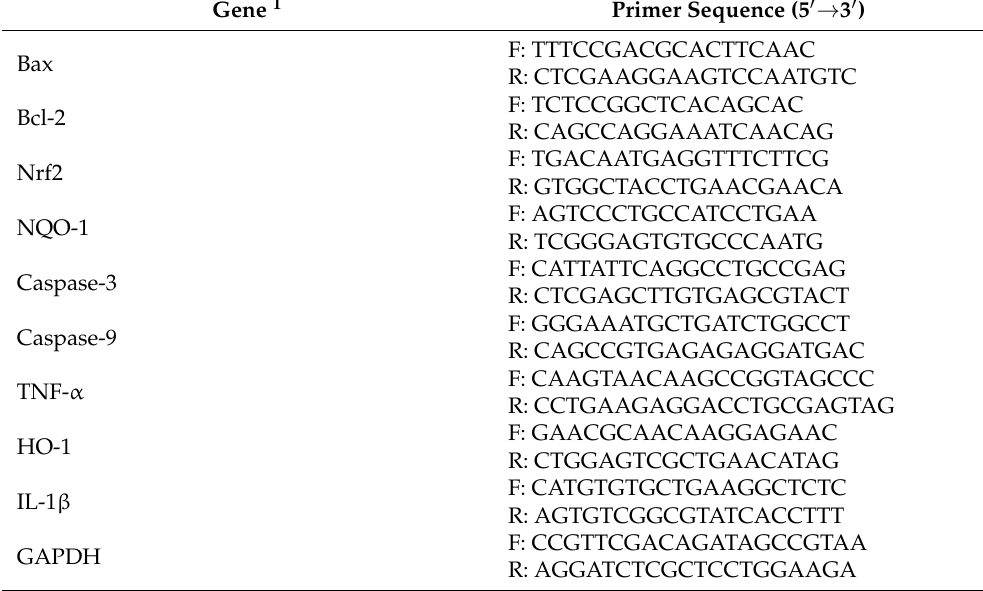
Table 3. The gene primers of